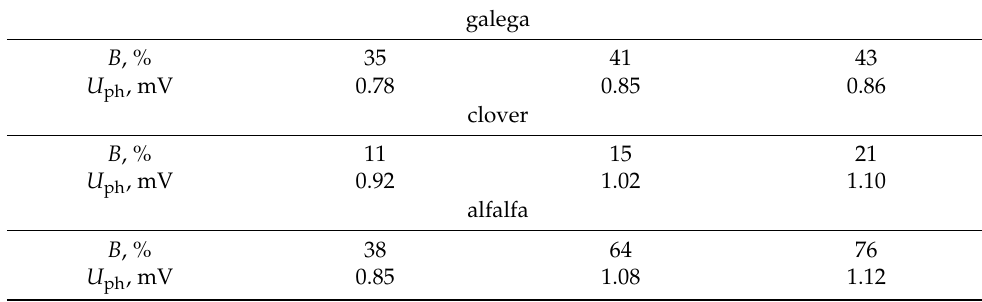
Table 4. The results of measuring the photon voltage U ph when excited by light of different germi- nation seeds after scarification.